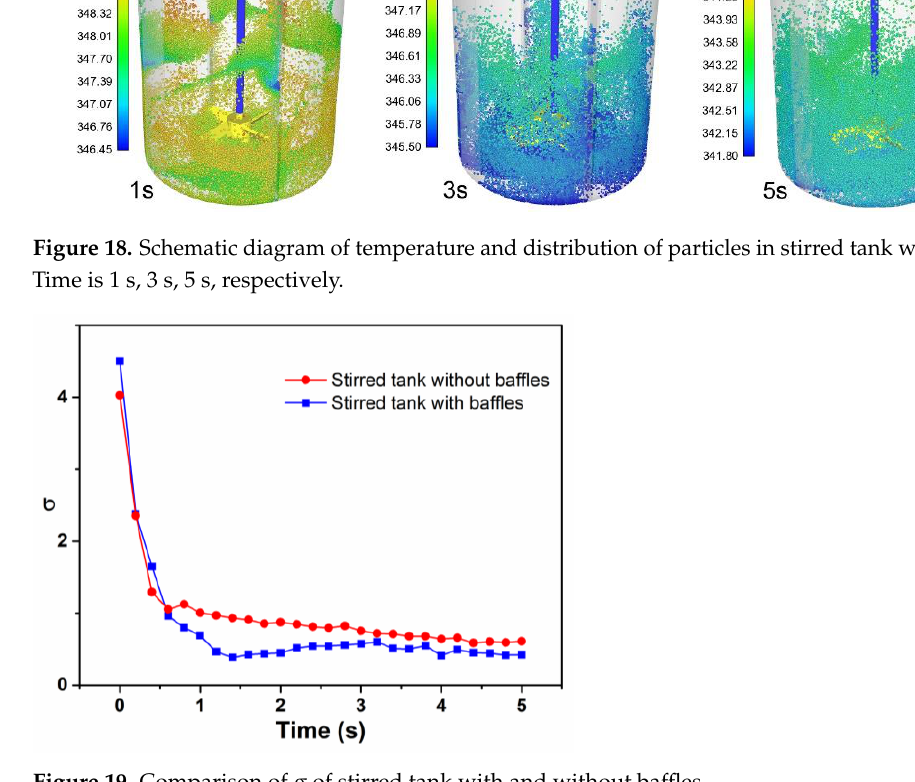
Figure 19. Comparison of σ of stirred tank with and without baffles.